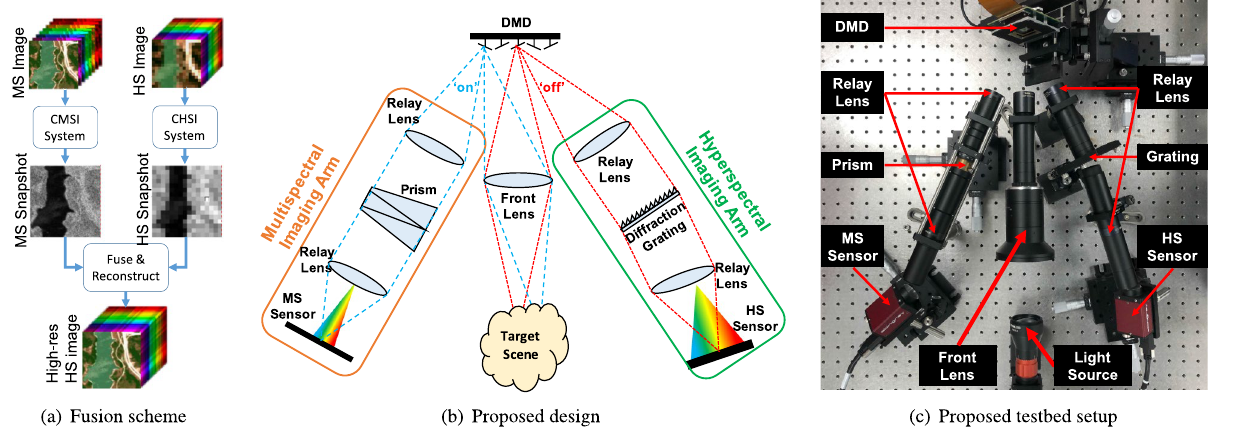
Figure 1. Proposed compressive spectral image fusion (CSIF) system. ( a ) Snapshots are acquired with a compressive MS imager (CMSI) and a compressive HS imager (CHSI), which are then fused and reconstructed via a computational algorithm. ( b ) Sketch of the proposed design, and ( c ) Proposed testbed setup. The front lens images the target scene onto the DMD, which encodes and reflects the scene towards ± 24 MS and HS imaging arms are located. Both imaging arms employ 4F relay lenses to transmit the encoded light to the sensors, either through the prism, or through a